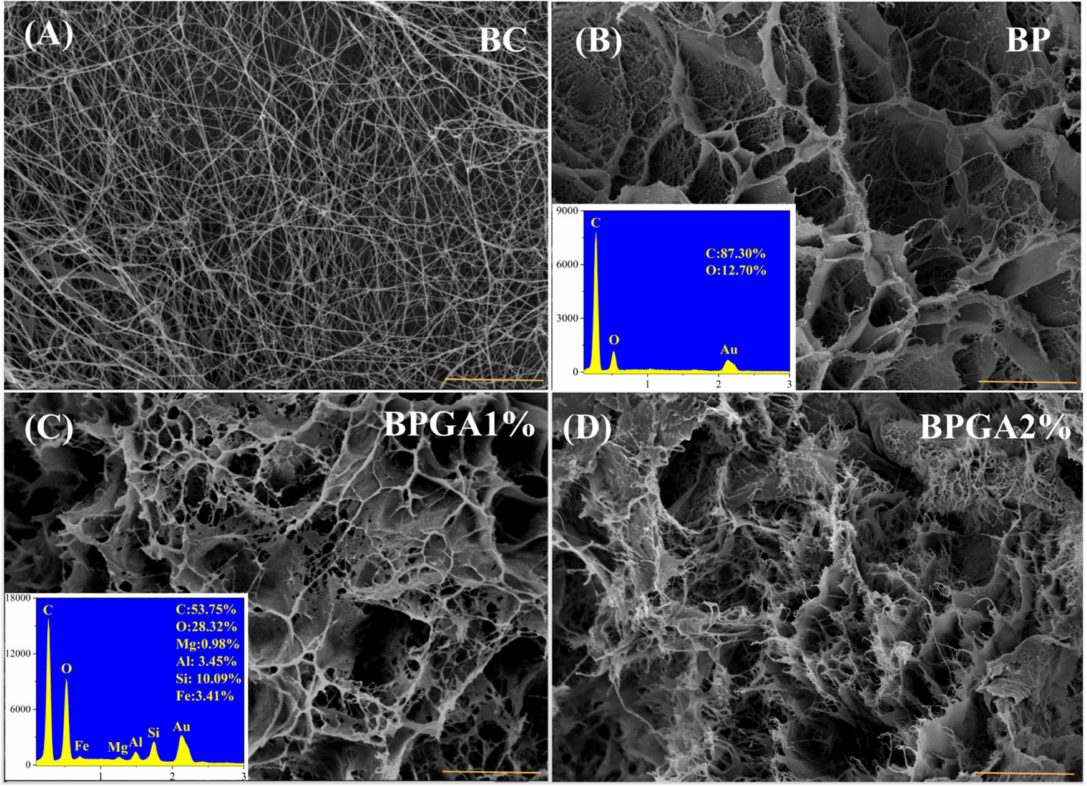
Figure 4. SEM images of the prepared adsorbent materials, (the insets are the EDS spectra with a scale bar of 5 µ m). ( A ) BC, ( B ) BP, ( C ) BPGA1%, ( D )